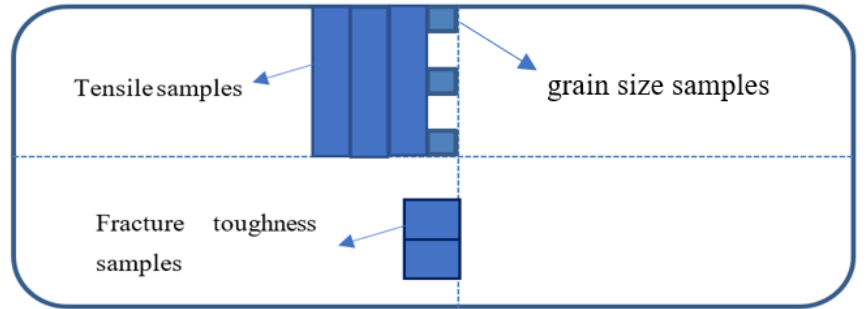
Figure 1. Samples locations for 7050 ingot.